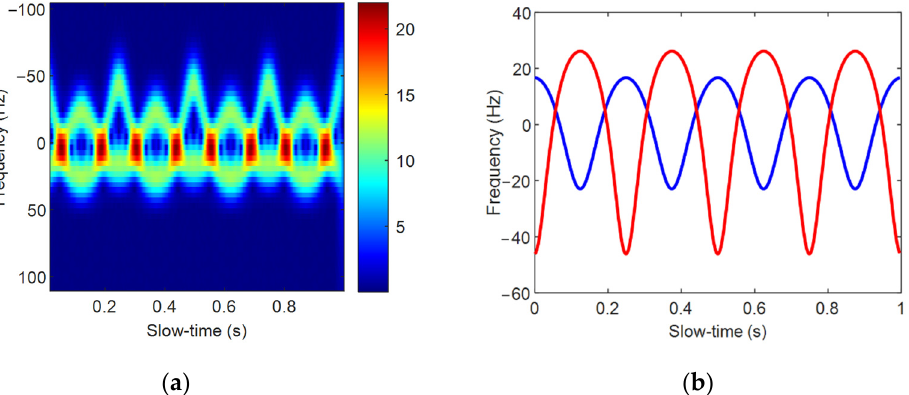
Figure 21. The angular Doppler effect in [24]. ( a ) Echo angular Doppler curve. ( b ) Theoretical angular Doppler curve.